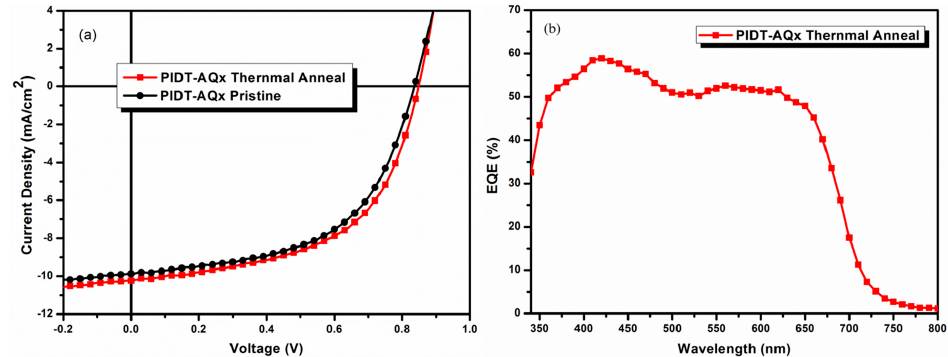
Figure 5. ( a ) The J – V curves of the pristine device and the annealed device and ( b ) the external quantum efficiency (EQE) spectra of the annealed device . Table 2. Photovoltaic performances of the polymer solar cells (PSCs) based on PIDT-AQx:PC 71 BM.